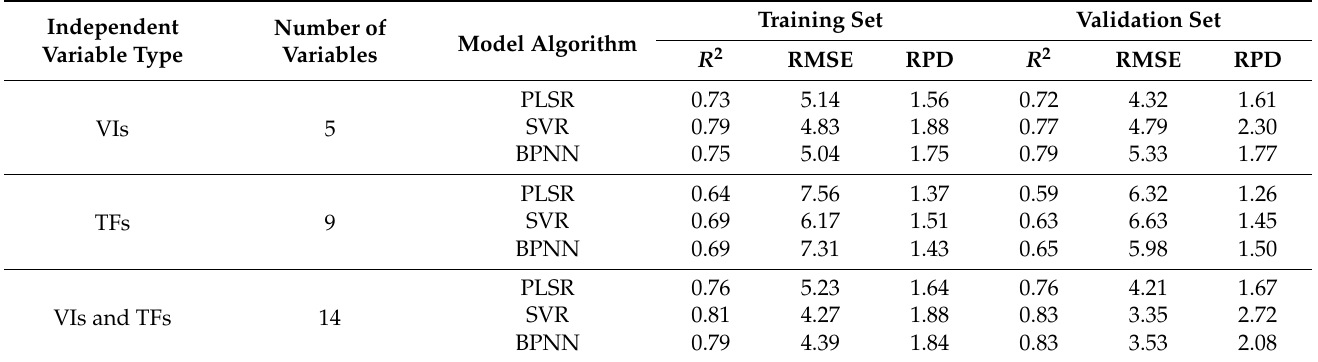
Table 4. Monitoring results of each model algorithm based on vegetation